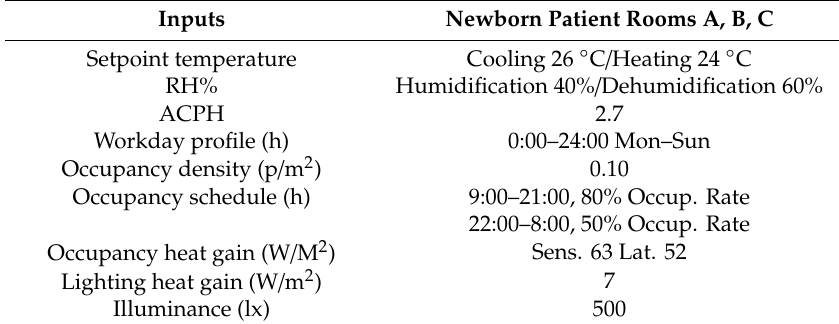
Table 1. List of parameters for the simulation of the building model. * Data provided by the Integrated Information Department of the